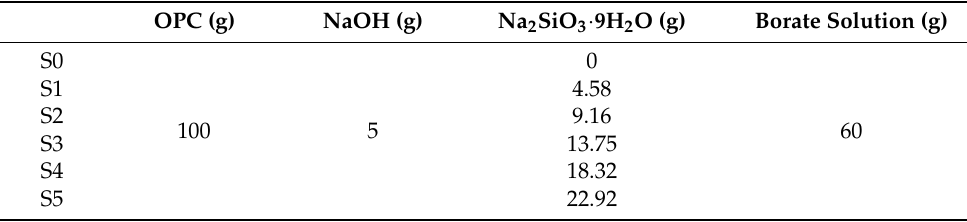
Table 3. Mix design of cemented waste